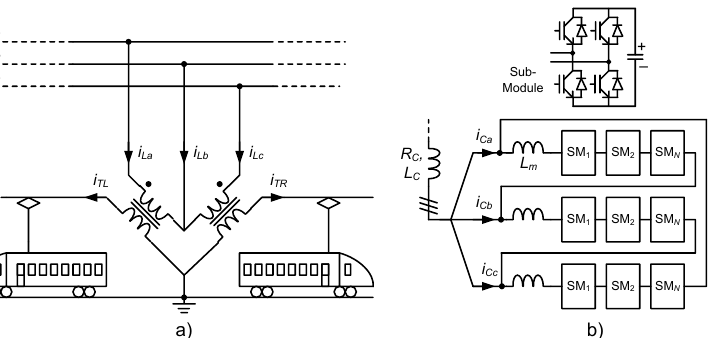
Figure 2. Examples of possible architecture for the V-V based TPSS ( a ) and possible solution for power structure of the electronic balancer using modular multilevel converter ( b ).